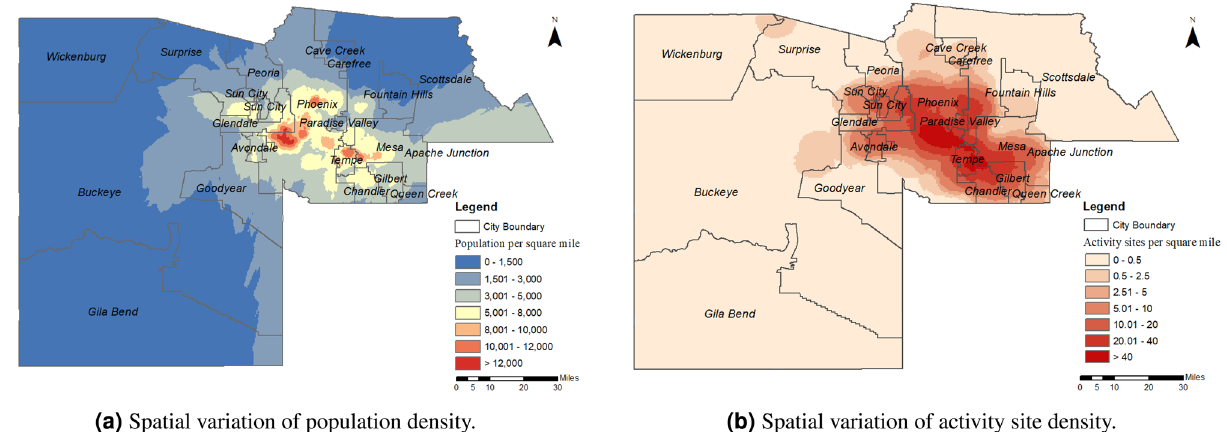
Figure 3. Spatial variation of the population and activity site densities in the Pheonix MSA. The developed multiscale SIRD pandemic model partitions the MSA into subregions according to the visualized subregion